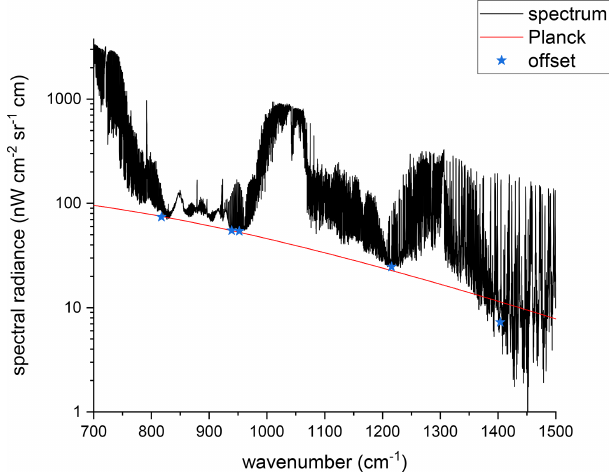
Figure A1. Median calibrated deep-space spectrum, together with the offset values at five spectral points and a Planck function fitted to the offset points. This was taken during the SouthTRAC campaign on 8 September 2019 at 07:53Z. Please note the logarithmic scale.